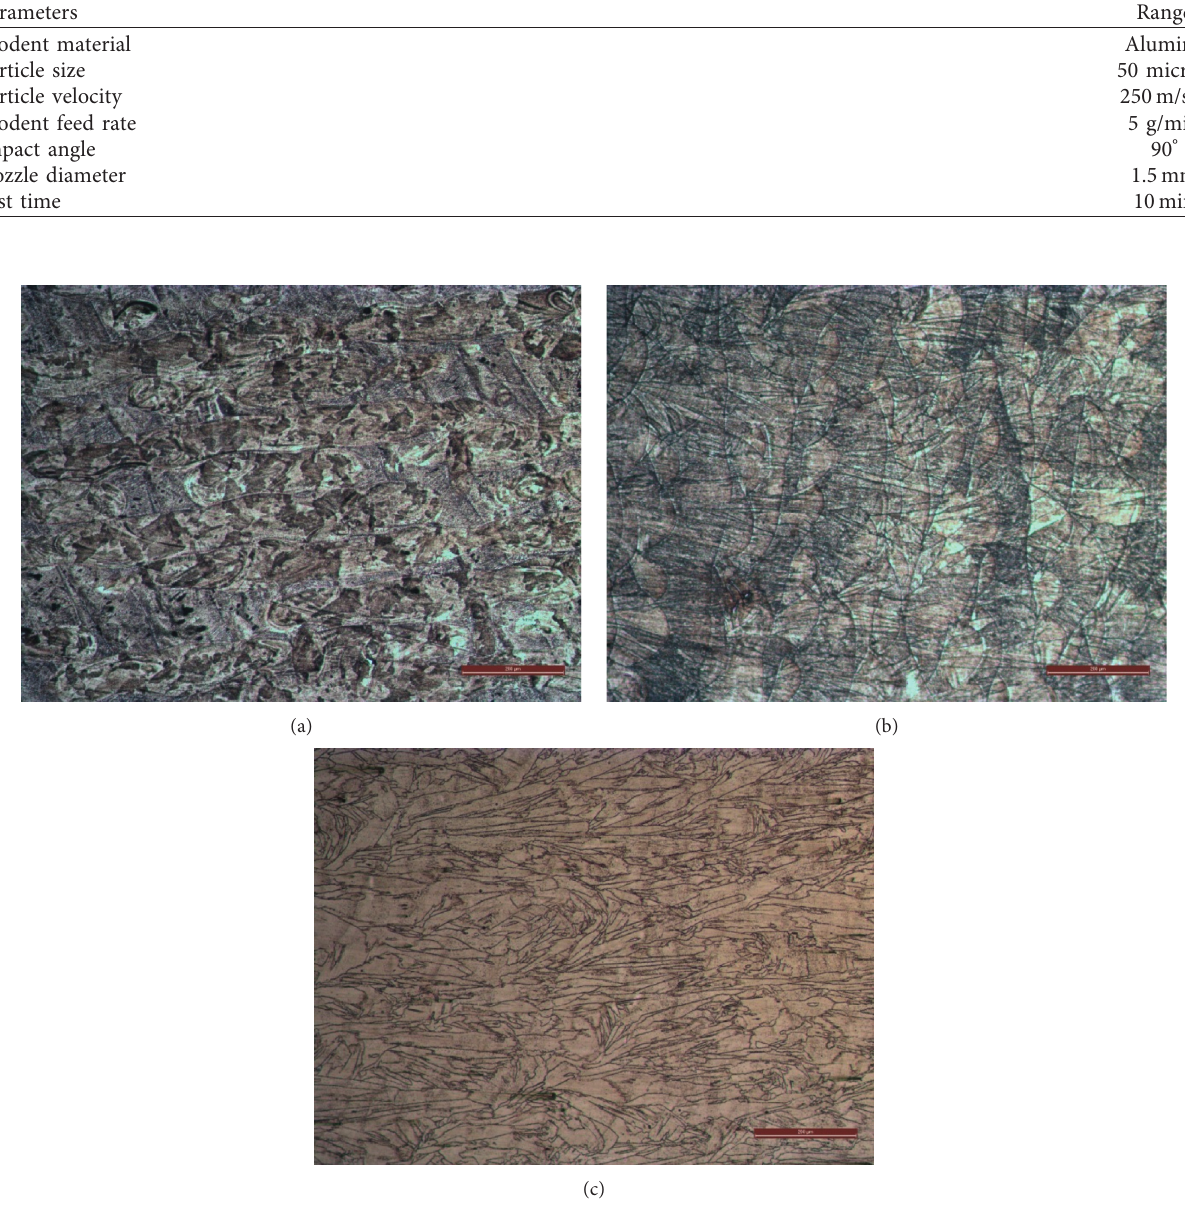
Table 4: Erosion test parameter for the proposed